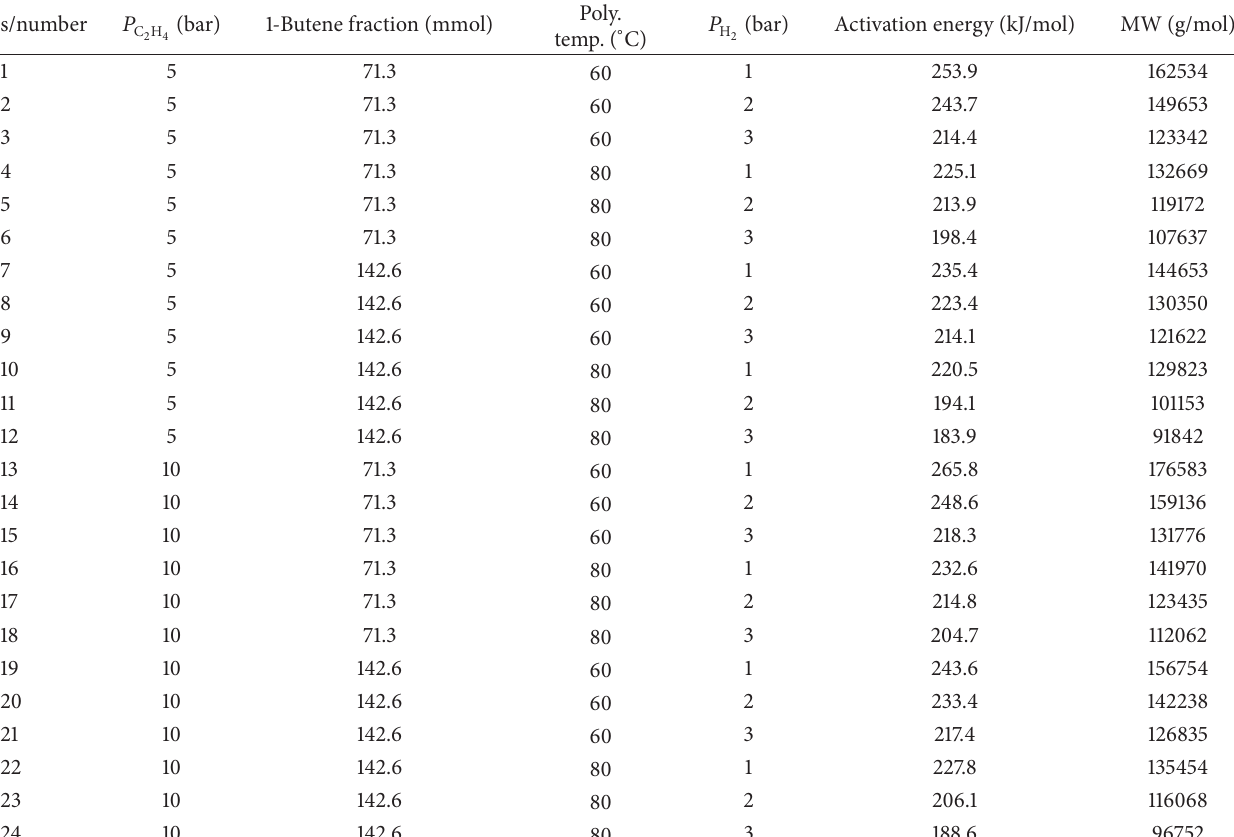
Table 2: Activation energy for copolymer samples (polymerization time: